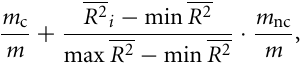
FIGURE 1 | Power results when casual loci have same effects under 4 causal loci out of 12 markers setting for binary trait. Power is calculated over 500 replicate data sets with α = 0.05; there are 495 possible combinations of 4 causal loci out of 12 markers; boxplots summarize the